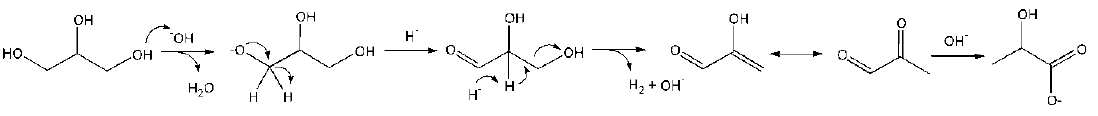
Figure 3. A schematic conversion of glycerol into lactic acid in the volume.